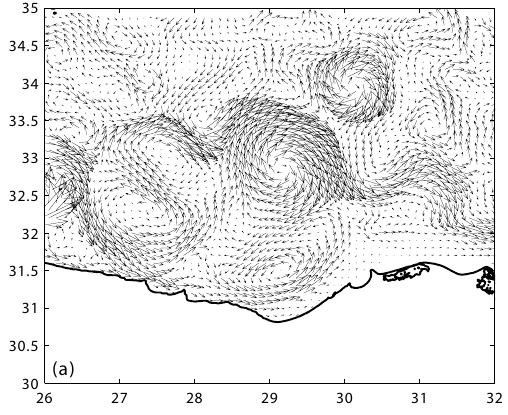
Fig. 14. As in Fig. 13 but for (a) 10 March and (b) 30 March.